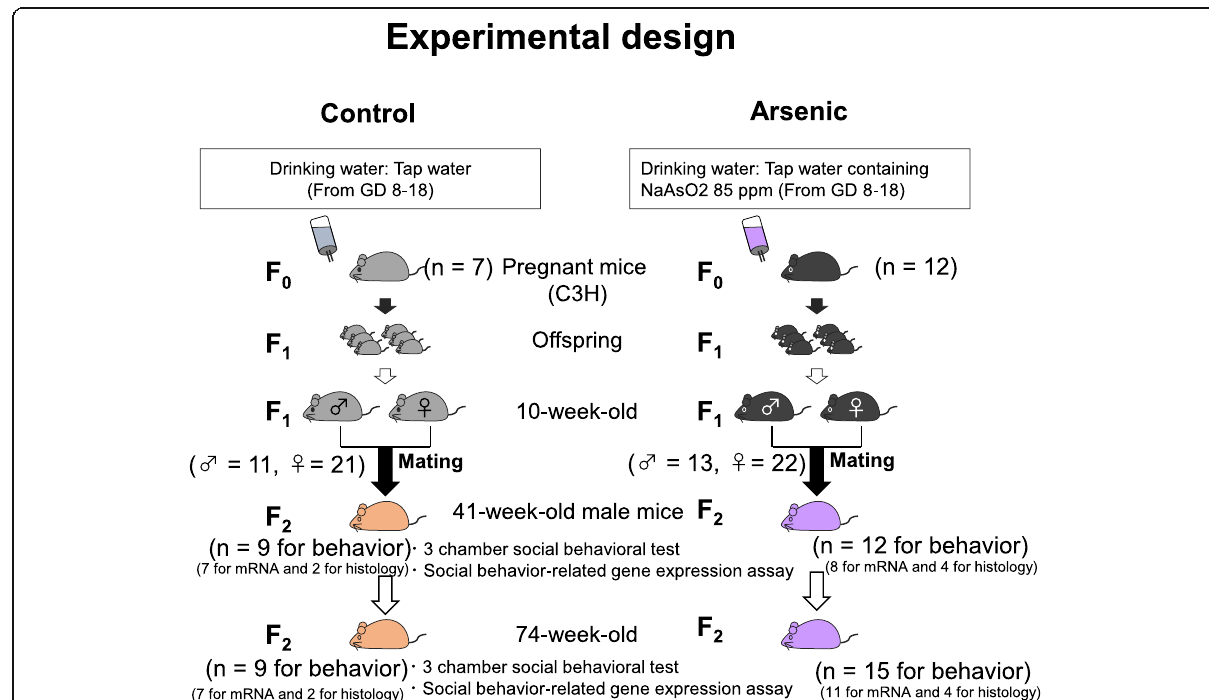
Fig. 1 Experimental design. Pregnant C3H/HeN mice (F0) ( n = 19) were used in this study. The arsenite mice (F0; n = 12) were exposed to sodium arsenite (NaAsO 2 , 85 ppm (85 mg/L) in the drinking water) from gestational days (GD) 8 to 18. The control mice (F0; n = 7) were given (arsenic free) tap water. The F1 male and female pups were weaned at postnatal day 21. At the age of 10 weeks, a mating was done among the control F1 males and females (1:2) to generate the control F2 mice. Similarly, to generate the arsenite-F2 mice, the arsenite-F1 males and females were mated (1:2). The F2 male pups ( n = 18 for the control group: n = 27 for arsenite group) were weaned at postnatal day 21. At the age of 41 weeks, the control male mice ( n = 9) and arsenite male mice ( n = 12) were used for social behavior test and molecular analyses. At the age of 74 weeks, the control male mice ( n = 9) and arsenite male mice ( n = 15) were used for social behavior test and molecular